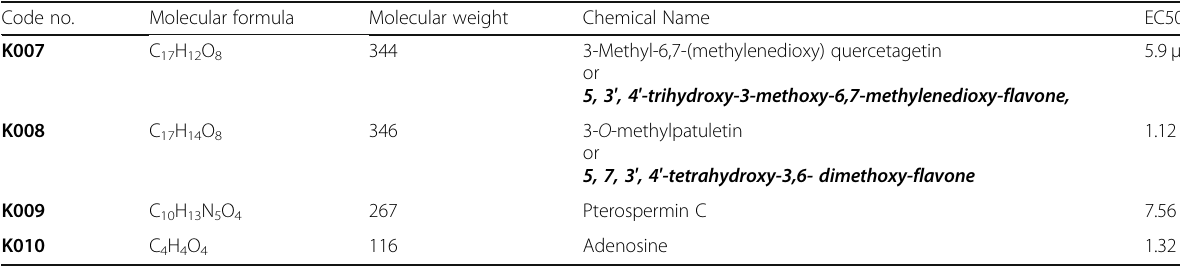
Table 3 Compounds isolated from extract of Spinacia oleracea Code